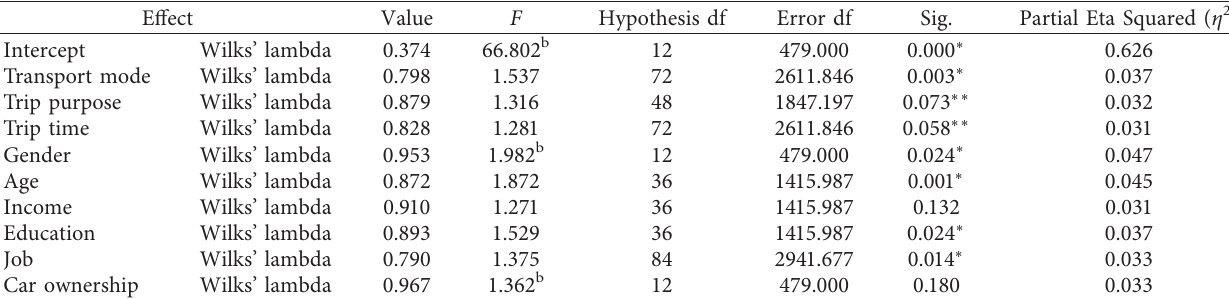
Table 9: The tools carried by travelers across variables (i.e., groups): the results of the multivariate analysis test a . Effect